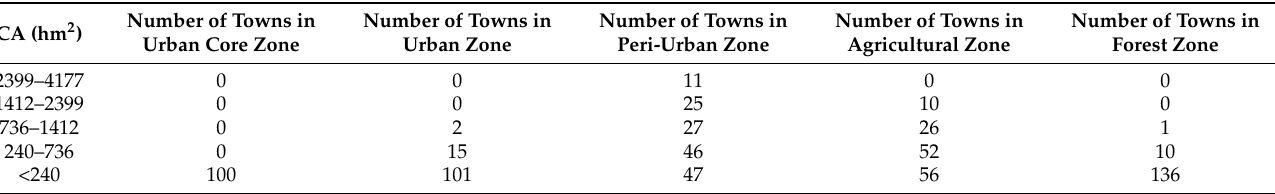
Table 4. Number of towns in the Pearl River Delta classified by pond total area